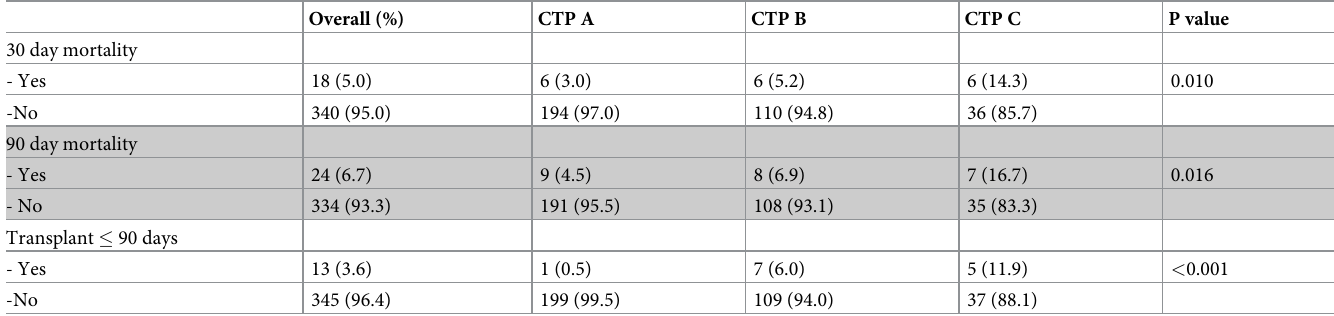
Table 3. CTP mortality and 90 day transplant rates.